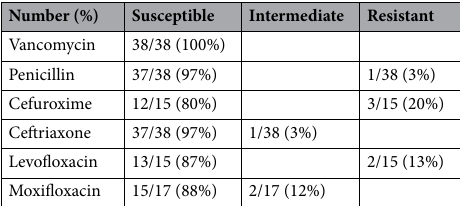
Table 3. Antibiotic susceptibility testing of Streptococcus pneumoniae in patients with endophthalmitis.